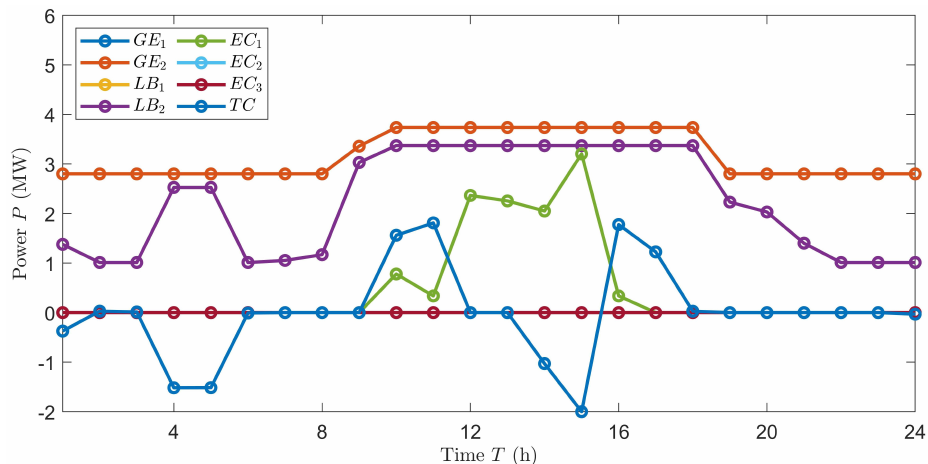
Figure 12. Operation of equipment in cooling season (high gas